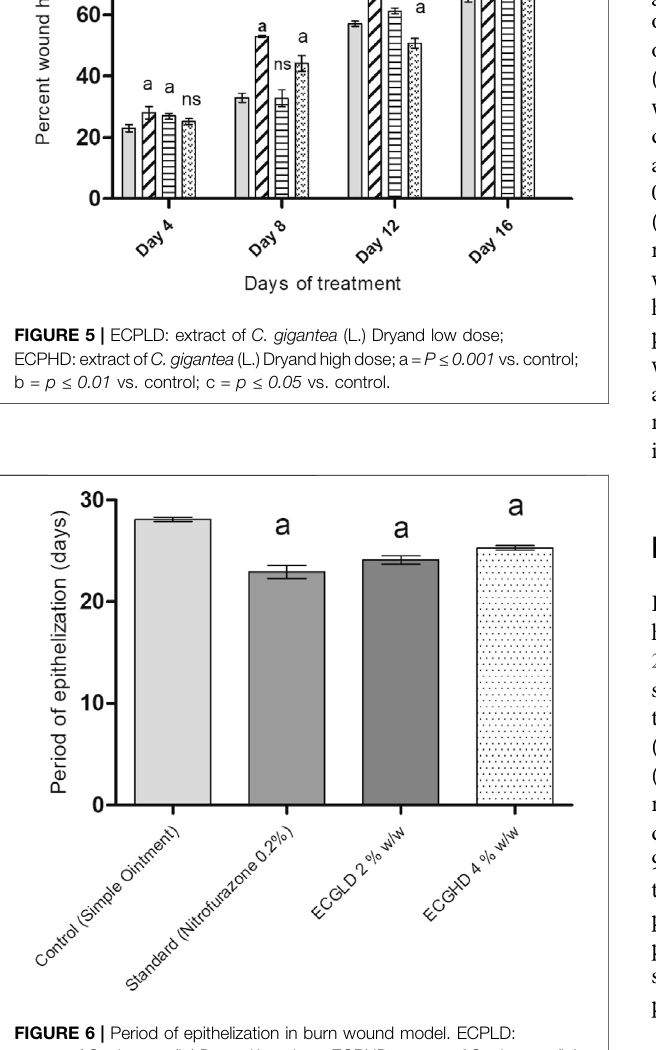
FIGURE 6 | Period of epithelization in burn wound model. ECPLD: extractof C.gigantea (L.)Dryandlowdose; ECPHD:extractof C.gigantea (L.) Dryand high dose; a (cid:2) P < 0.001 vs. control; b (cid:2) P < 0.01 vs. control; c (cid:2) P < 0.05 vs. control.